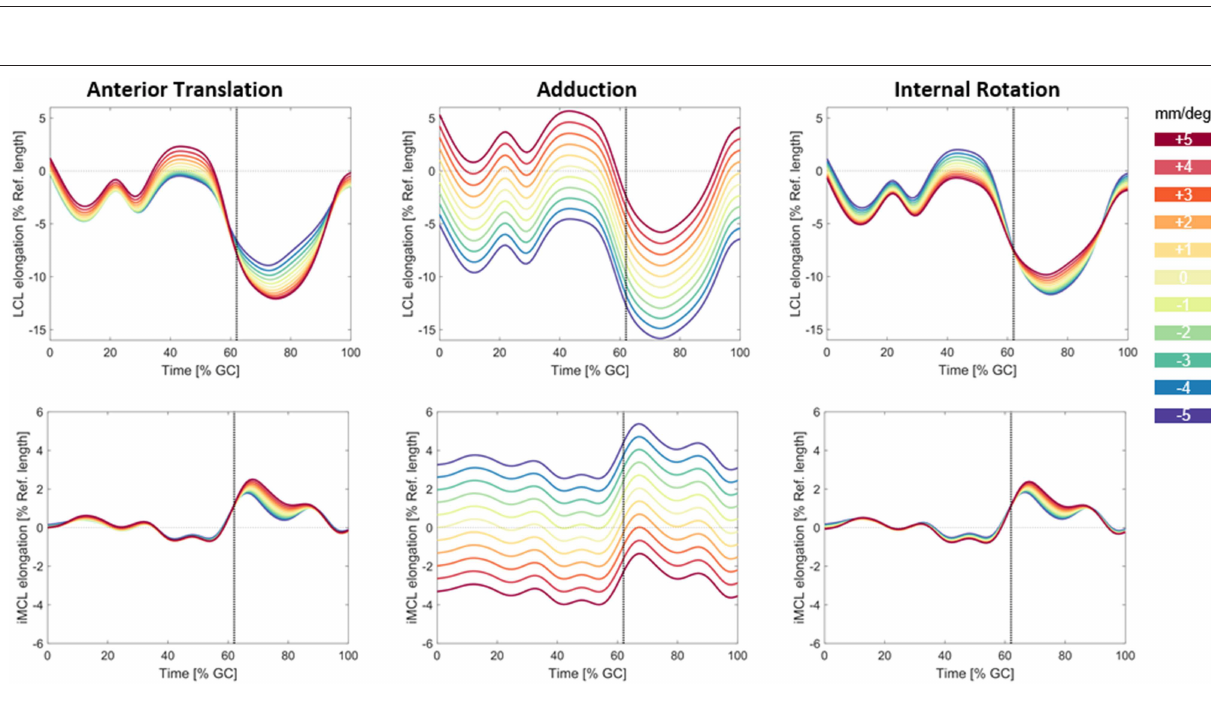
Frontiers in Bioengineering and Biotechnology | www.frontiersin.org